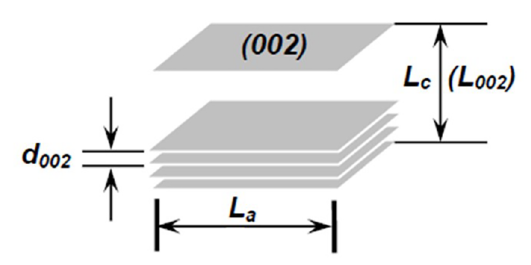
Figure 1. Schematic of a graphitic crystallite with their crystallographic parameters